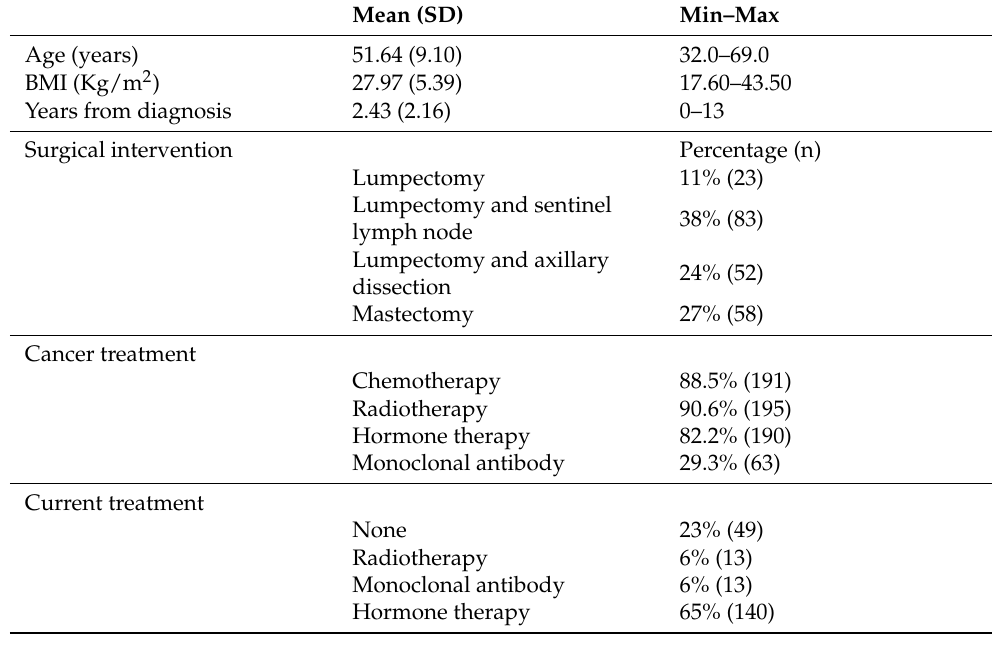
extracted (Figure 1). Table 1. Participant descriptive and clinical variables.